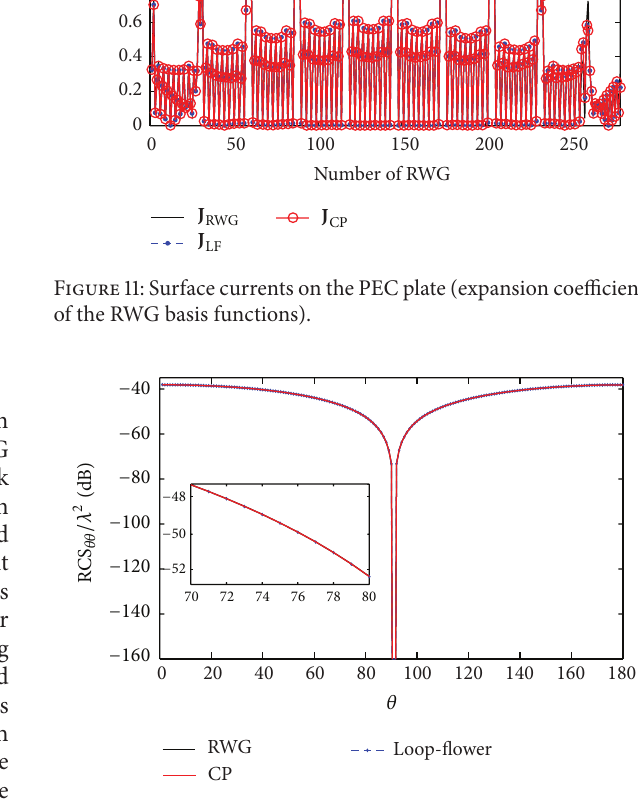
Figure 12: BiRCSs of the PEC